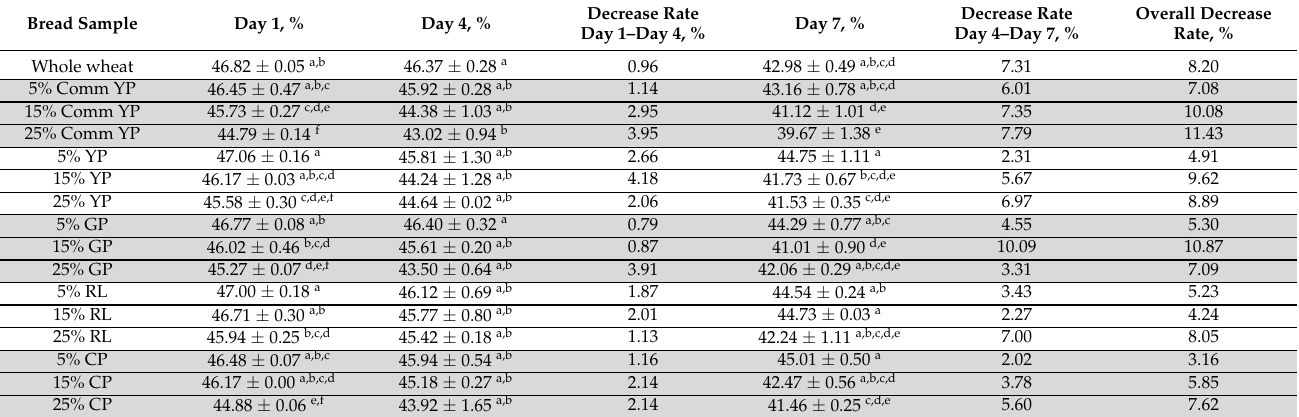
Table 6. Moisture content of whole wheat/pulse bread during